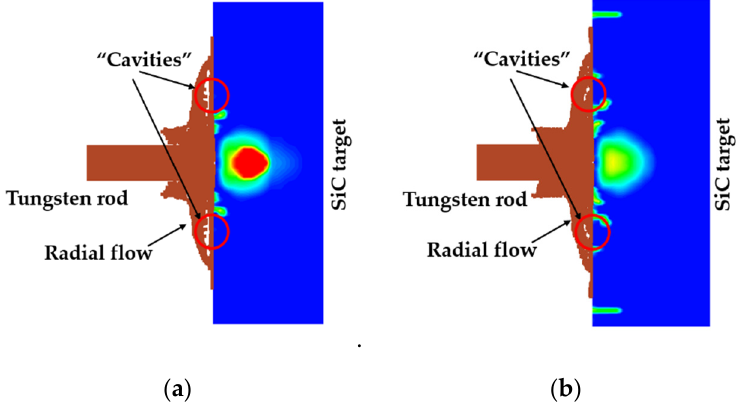
Figure 10. Comparison of the radial flow pattern in cases with the 6 mm and 7 mm fixed cover plates at the same dwell time of 18 μ s. The impact velocity is 1400 m/s. The cover plate and the tube are not shown. ( a ) t cp = 6 mm. ( b ) t cp = 7 mm.